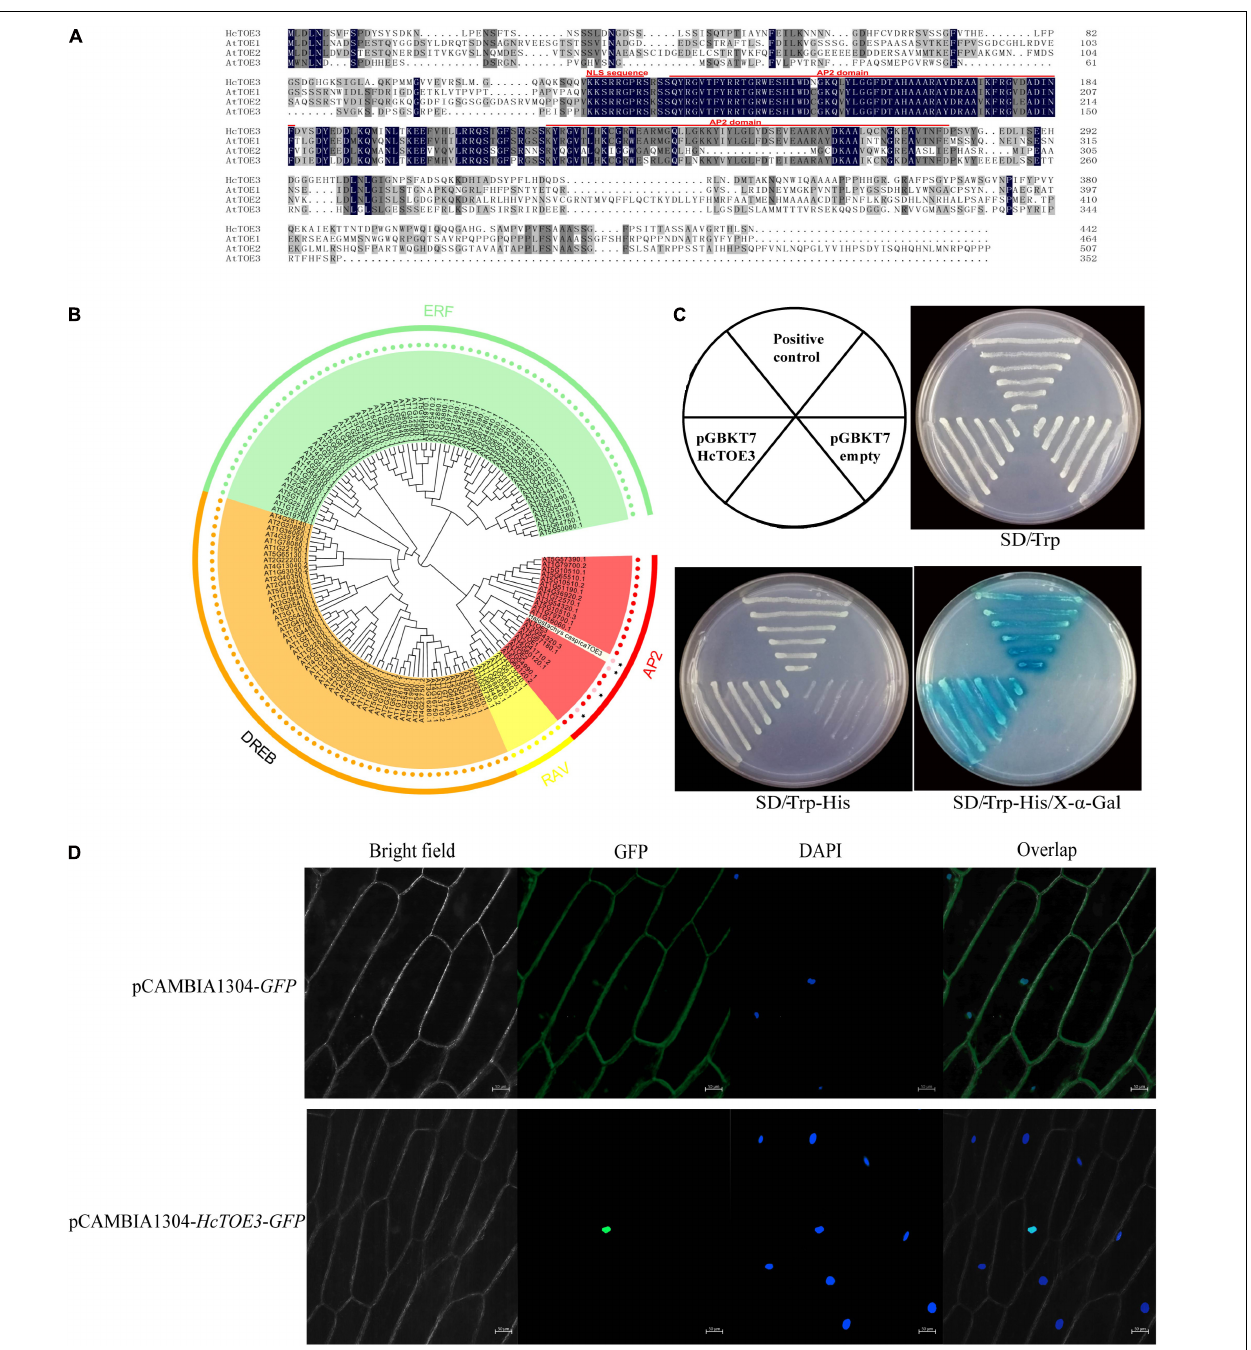
( Figure 5H ). To further confirm the above physiological data, we also examined the expression of the osmotic-related genes P5CS and the ROS detoxification-associated genes ( POD , CAT , and APX ). The qRT-PCR results demonstrated that freezing treatment induced the expression of all four tested genes more